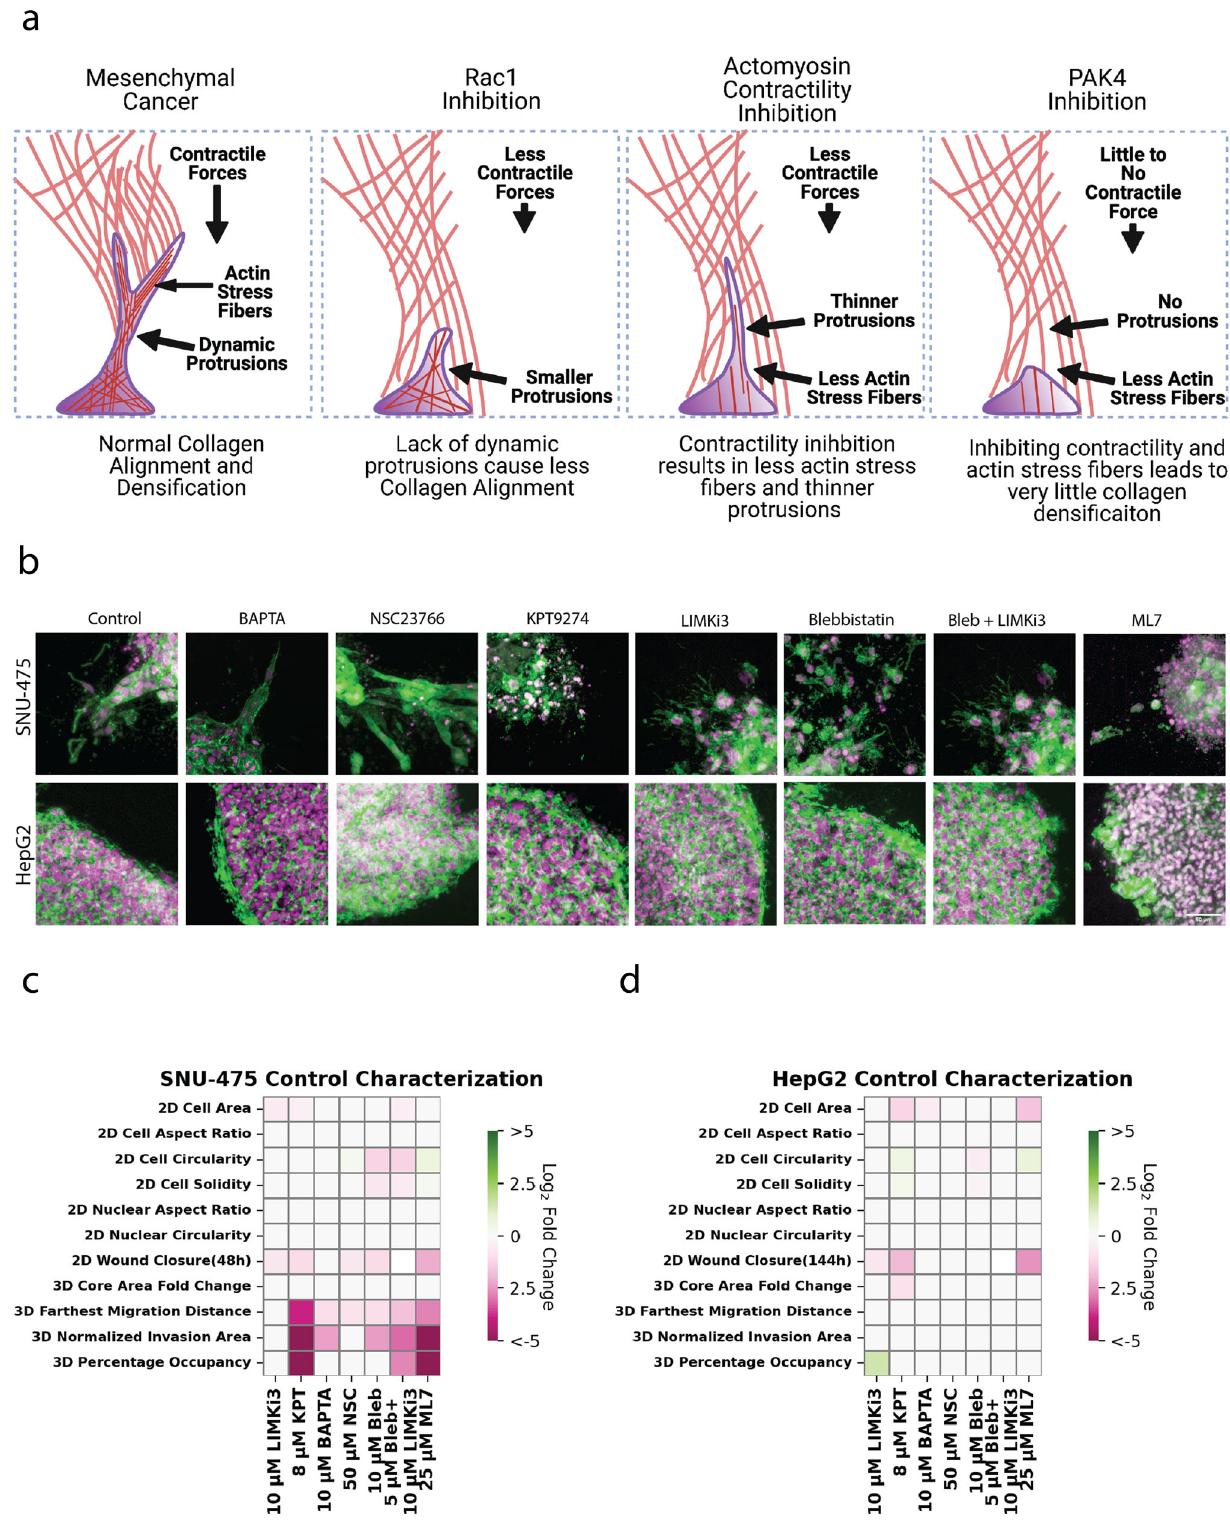
H 2 O, 10× PBS, and acetic-acid-solubilized type I rat tail collagen (Corning, Corning, NY, USA) on ice for a fi nal collagen concentration of 2 mg/ml. In order to track collagen, we fl uorescently label collagen with carboxylated polystyrene Alexa- Fluor 660/680 beads (ThermoFisher Scienti fi c, cat.# F8807). Prior to depositing the collagen, plates used for collagen gel seeding were surface-coated with poly- dopamine, as previously described 60,61 . This coating allows collagen gels to stick to the surface of the plates and prevents detachment of the gel.